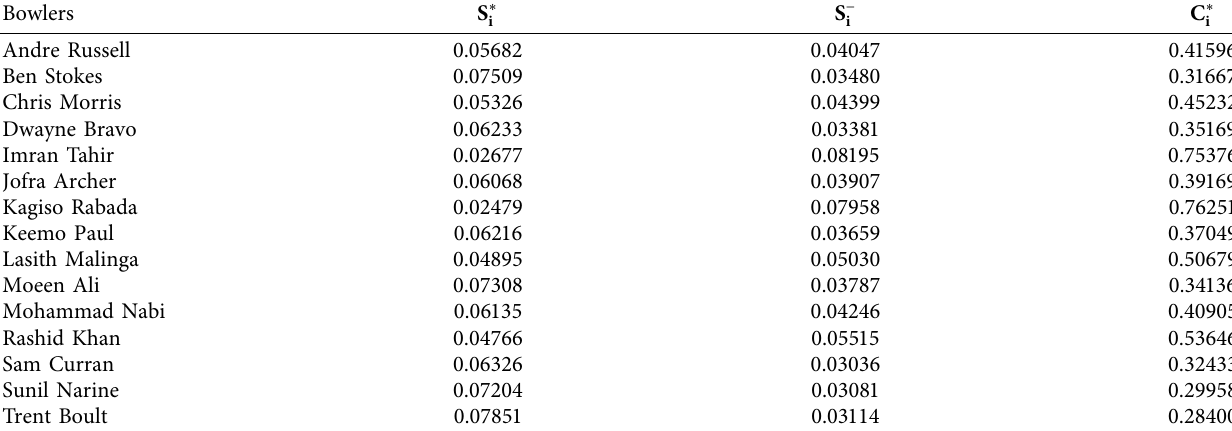
Table 6: Distance values for bowlers.